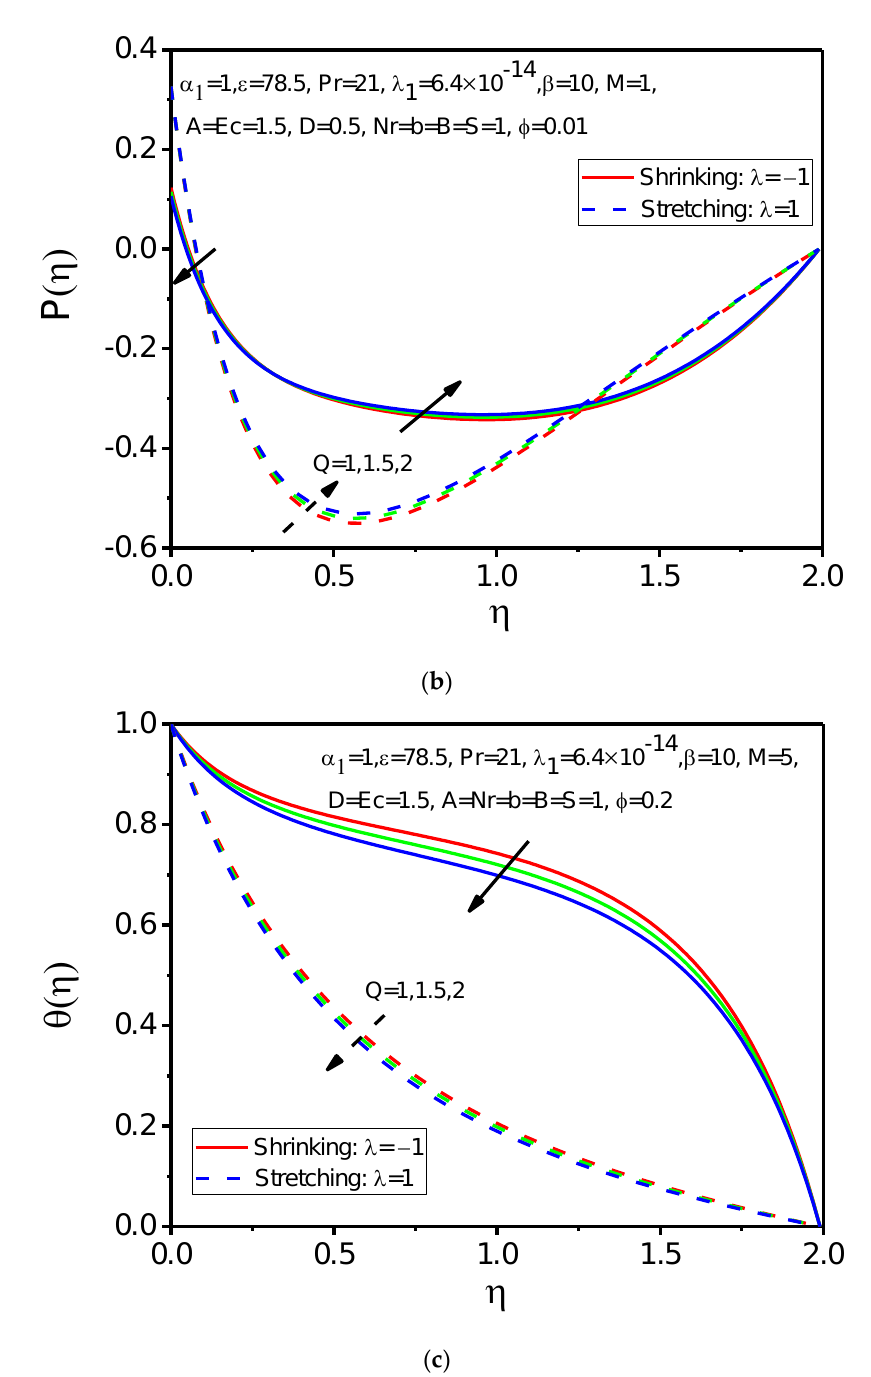
Figure 12. Variation of Q on ( a ) Velocity profile, ( b ) Pressure profile, ( c ) Temperature profile. Figures 13–17 exhibit the skin friction coefficient and rate of heat transfer for several values of the ferromagnetic interaction parameter, curvature parameter, magnetic field parameter, volume fraction of magnetic particles and unsteadiness parameter. Figures 13a and 14b depict the variation of skin friction coefficient and rate of heat transfer for ferromagnetic number and curvature parameter, respectively with regard to the magnetic field parameter for stretching and shrinking cases. From Figure 13a, it is seen that increment values of β skin friction − f (cid:48)(cid:48) ( 0 ) are enhanced in both cases. The reverse behavior is noticed for the rate of heat transfer (see Figure 13b); where − θ (cid:48) ( 0 ) decreases for the stretching case while increases for the shrinking case. Moreover, for increasing values of the curvature